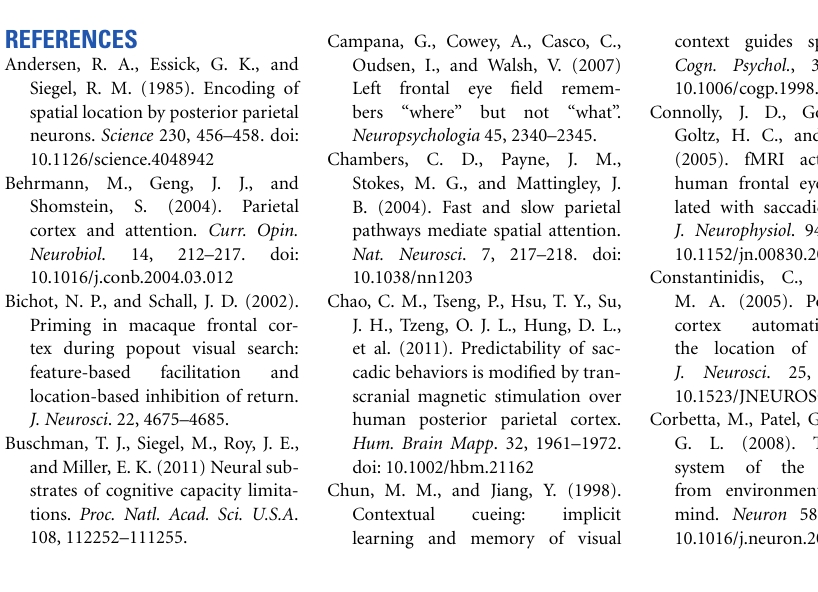
FIGURE 4 | FEF TMS effects on the saccade latencies of pro- and anti-saccades were found in two distinct time windows suggesting that the stages of visual selection and motor preparation can be temporally separated in FEF, results from Juan et al. (2008). Panel (A) shows a significant effect of early TMS timing on prosaccade latency. Post-hoc comparisons showed that this was due to increased latencies